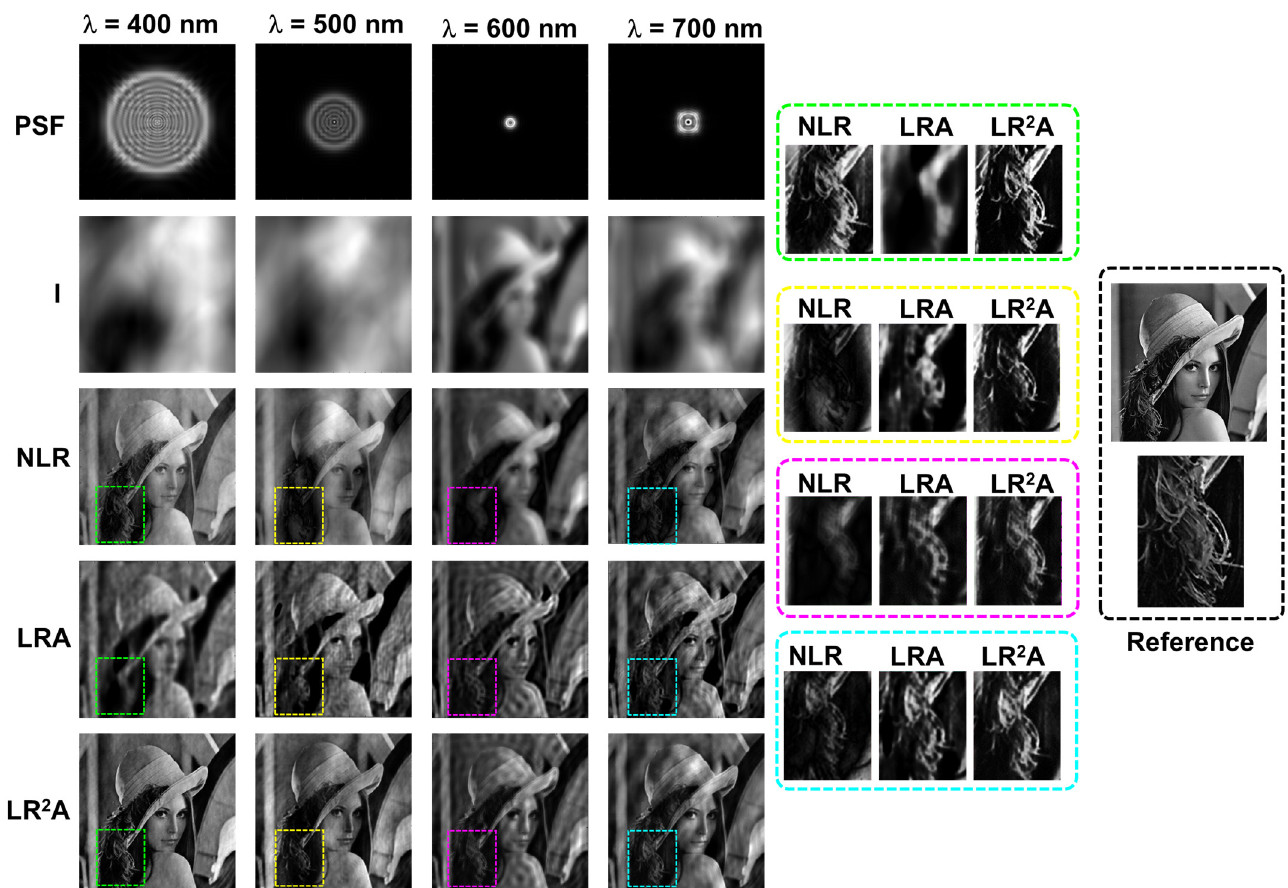
Figure 5. Deblurring results of NLR, LRA, and LR 2 A for di ff erent wavelengths λ = 400, 500, 600, and 700 nm resulting in di ff erent chromatic aberrations.